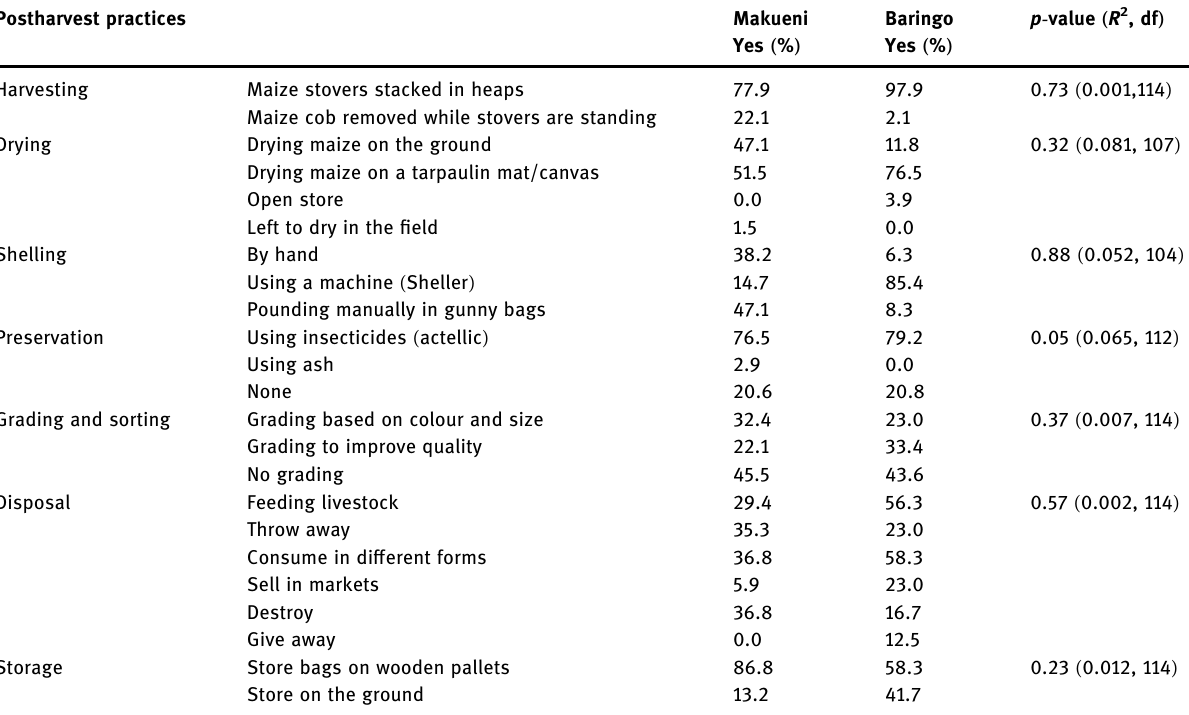
Table 3: Association of postharvest practices with a fl atoxin